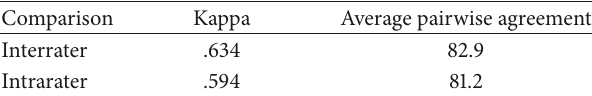
Table 2: Summary of